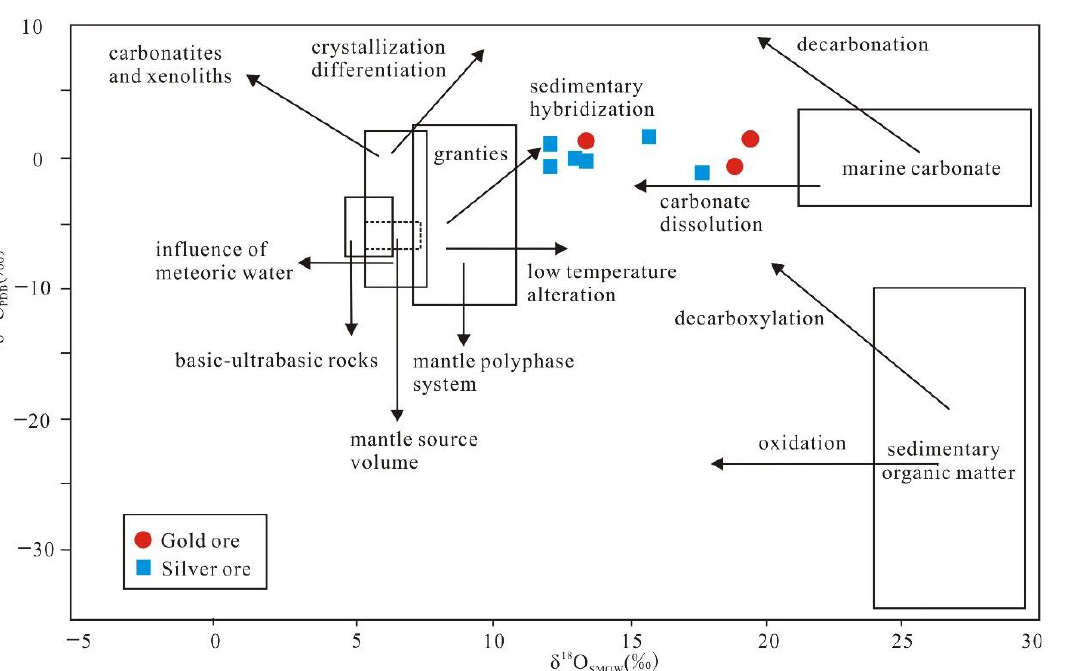
δ 18 O PDB vs. SMOW for the Changkeng–Fuwan Au-Ag deposit (from